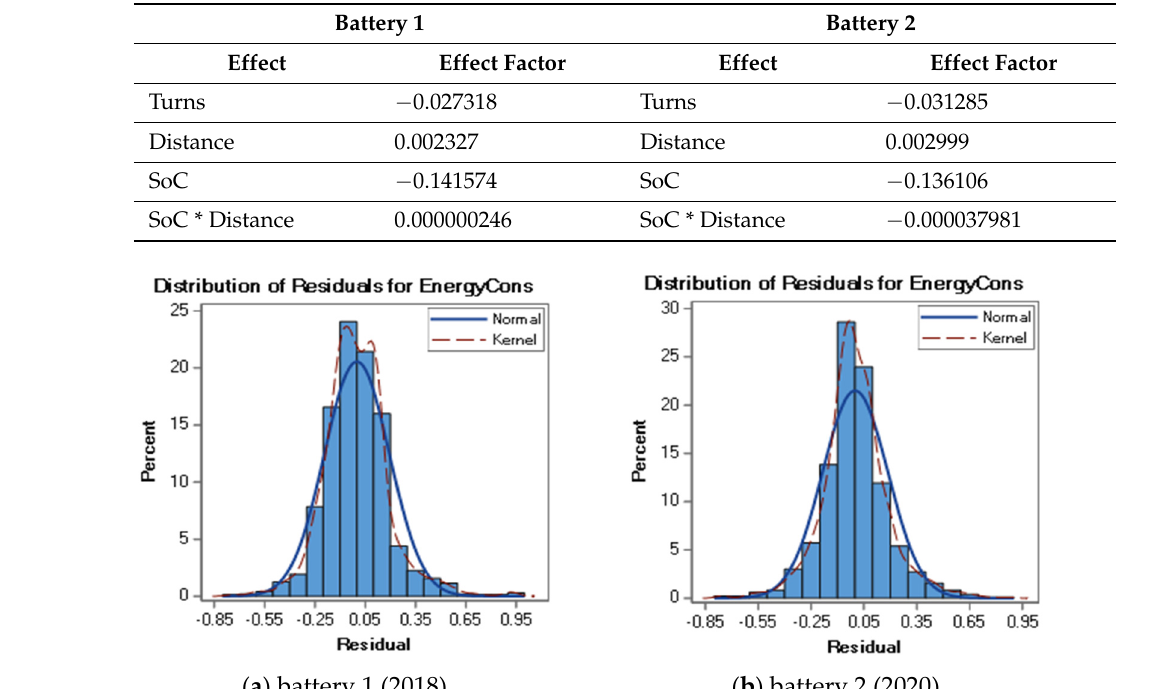
Table 6. Selected effects and their factors.